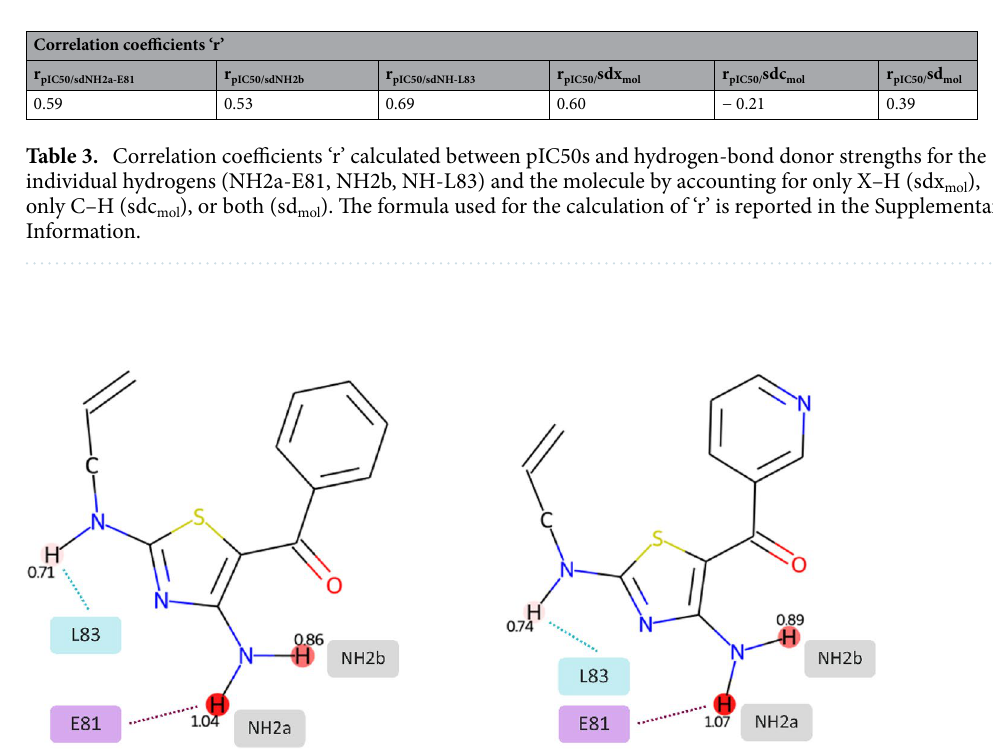
Figure 3. Atomic donor strength depictions for the compounds X02 (left) and X35 (right) produced by Jazzy. Donor strengths are annotated with their corresponding values and highlighted using a red gradient, where more intense colours indicate greater strengths. The difference in strength between the two symmetrical hydrogens (NH2a and NH2b) of each amine group denotes the ability of Jazzy of capturing the effect of conformations on the hydrogen-bond donor/acceptor strengths.